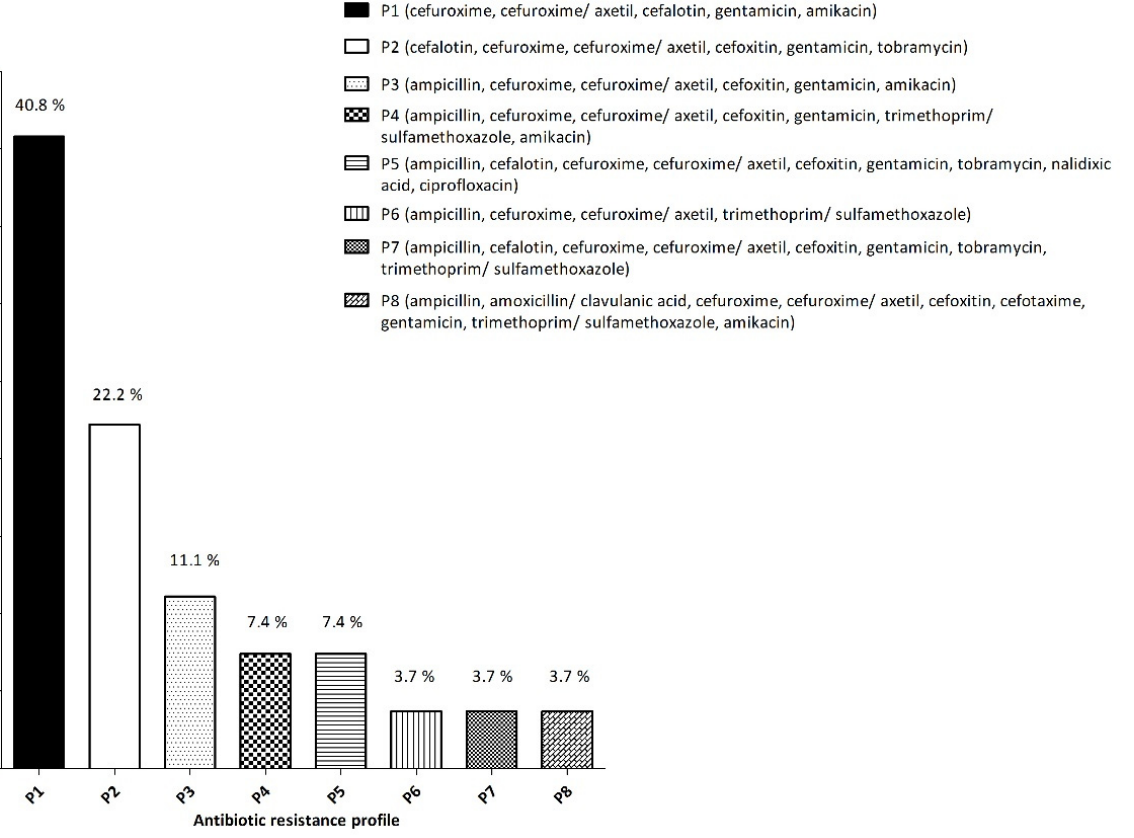
Figure 3. Antibiotic resistance profiles obtained from the 27 isolates.